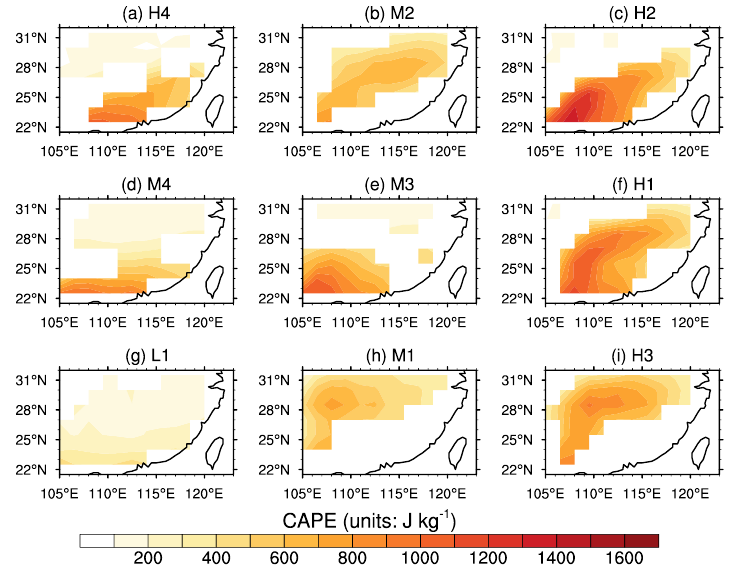
Figure 10. ( a – i ) Composite means of CAPE (units: Jkg − 1 ) for the nine regimes during AMJ 1979–2015. Only composite means that pass the 95% confidence level based on two-sided Student’s t test against the complementary set of samples are